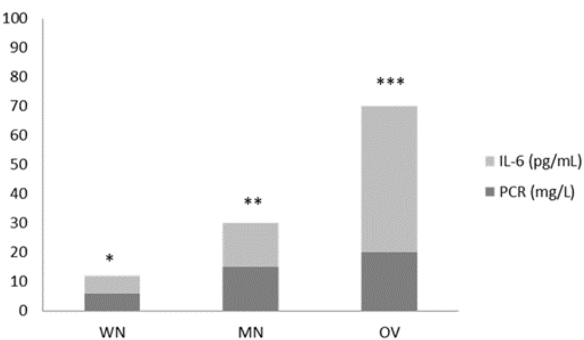
Figure 3. Reduction of inflammatory response markers (IL-6 and CRP) according to nutritional status in the IN group (T0 vs. T1; *, **, ***, all p < 0.05). A similar tendency was observed in the control group, without reaching statistical significance.